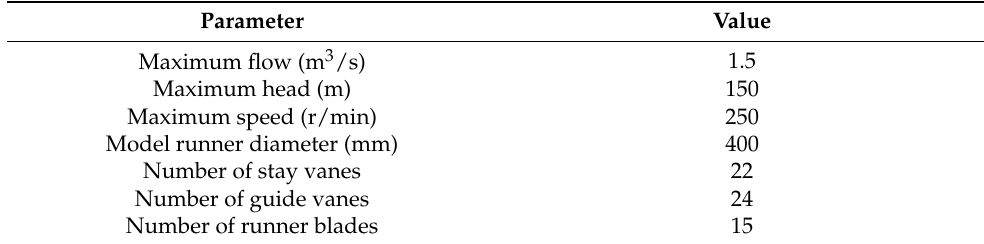
Table 2. Basic geometric parameters of the model turbine.